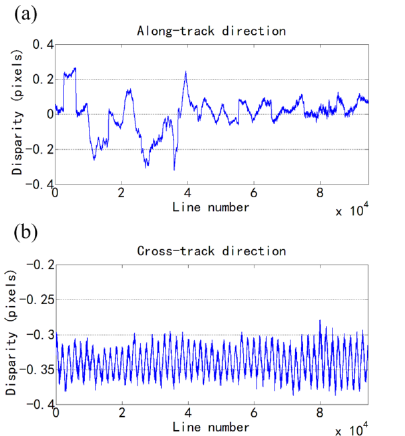
Figure 5. The mean parallax disparities of the 12 experimental images